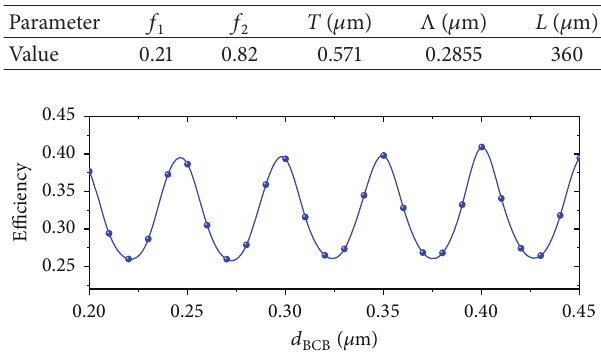
Table 1: Parameters of the binary blazed grating coupler.